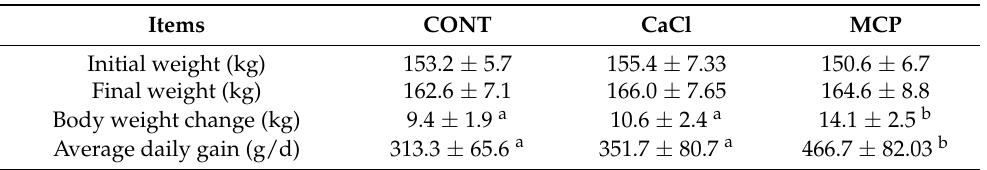
Table 2. Effects of calcium (Ca) and phosphorus (P) supplementation on the body weight of yak heifers (mean ± SD). CONT, control.